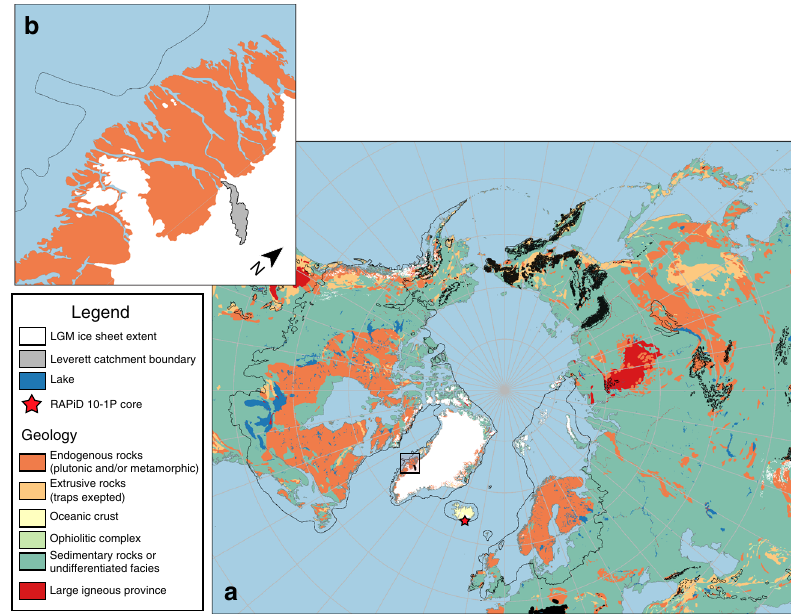
Fig. 3 Geological map of the Arctic with past ice sheet extent. a Arctic Polar Stereographic map with maximum palaeo-ice sheets extent (~21,000 years ago) indicated by a thick black line 17 , and insert ( b ) of the Leverett Glacier region (indicated by a red square on the west coast of Greenland in ( a )) where samples were taken. The estimated Leverett Glacier catchment 84 is shown in b by the fi lled grey area. Reproduced with the permission of OneGeology. Map created using